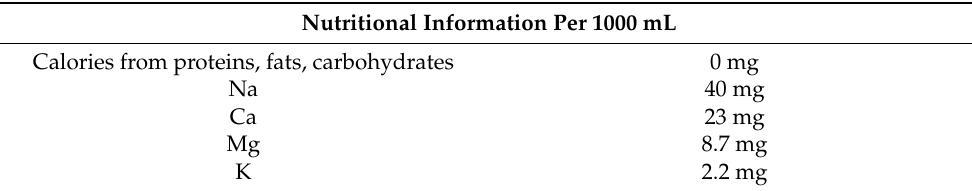
Table 4. Mineral content for Yunosato Gold mineral water (MW) as described on the bottle’s label. Nutritional Information Per 1000 mL Calories from proteins, fats, carbohydrates